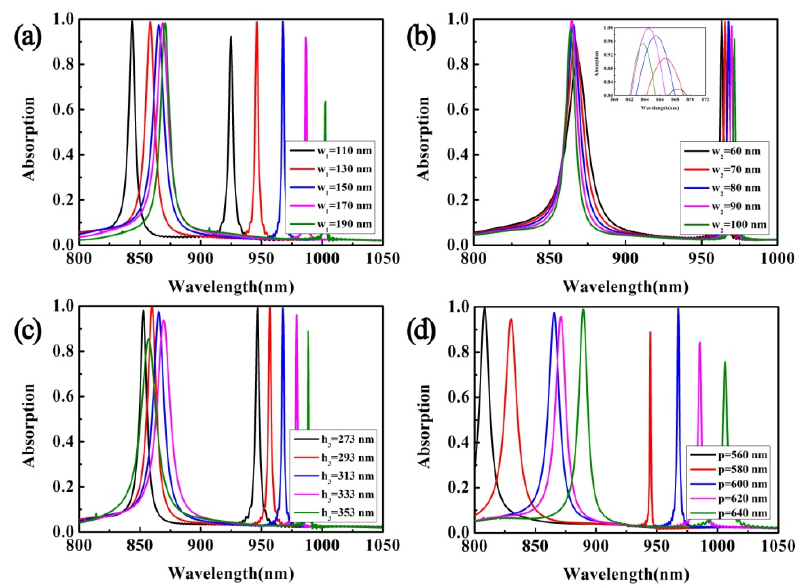
Figure 4. ( a – d ) The change of the absorption spectrum when changing the value of w 1 , w 2 , h 3 , and p.